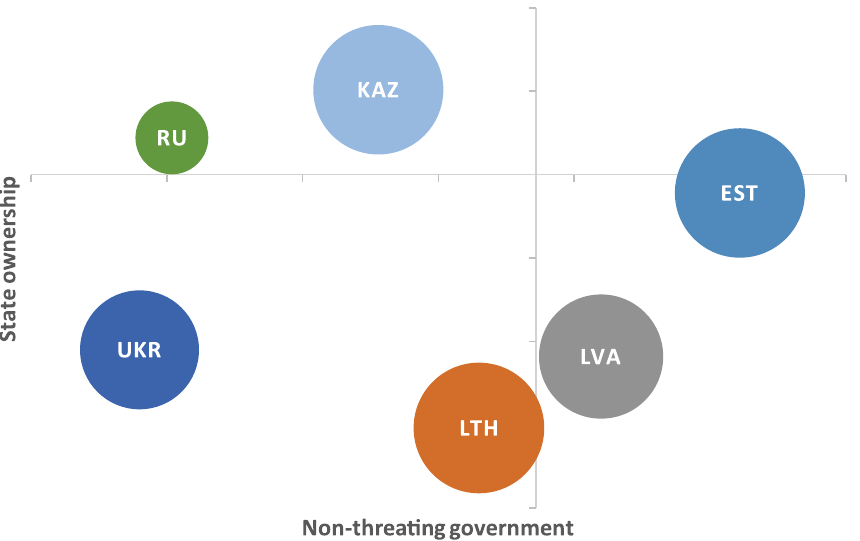
Figure 14. Varieties of state capitalism and the NIS efficiency (size of bubbles). Designed based on authors’ calculations and data sourced from